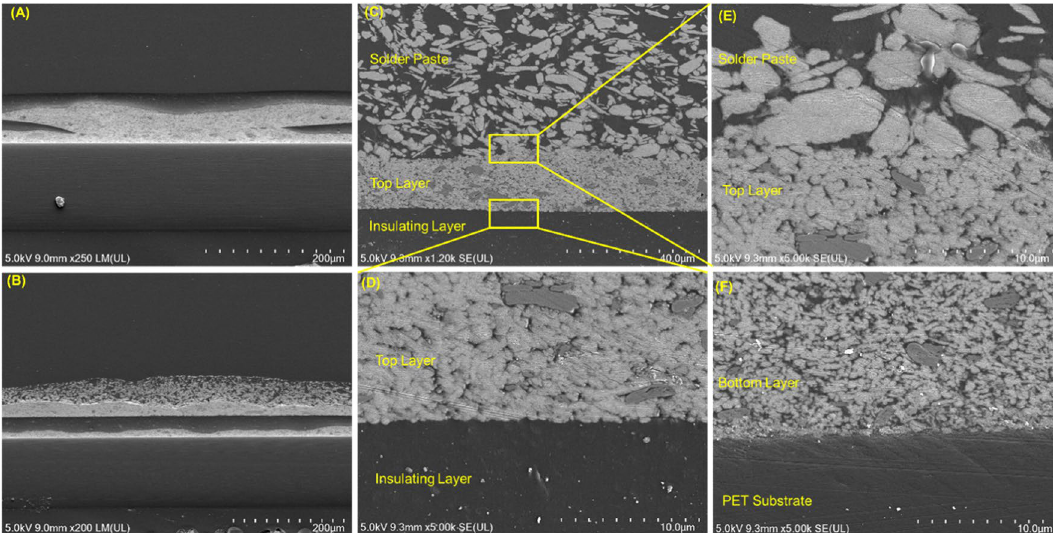
Figure 8. Microstructure of the printed layers. ( A ) Cross-section of the printed 4-layer circuit at the via-hole, ( B ) Cross-section at the pad to mount electronic components with printed solder paste, ( C – E ) connection between solder paste and the top conductive layer, the top conductive layer and the insulating layer, and ( F ) Connection of the bottom conductive layer and PET